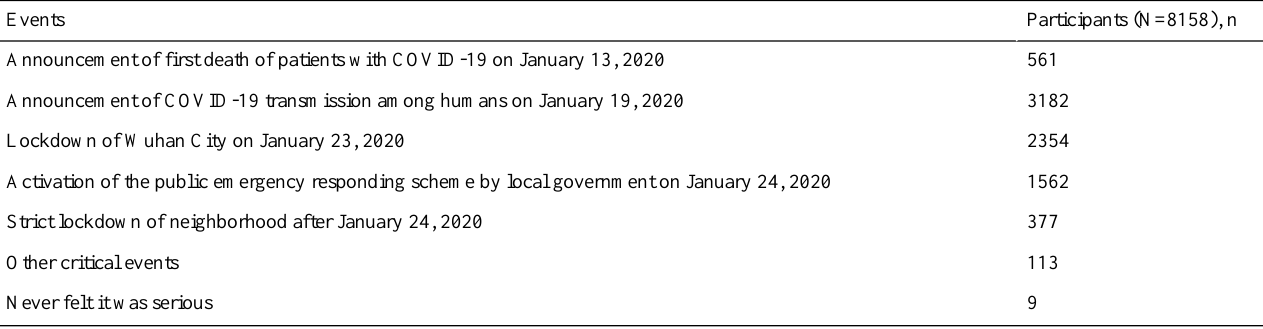
Table 2. When participants felt the situation was